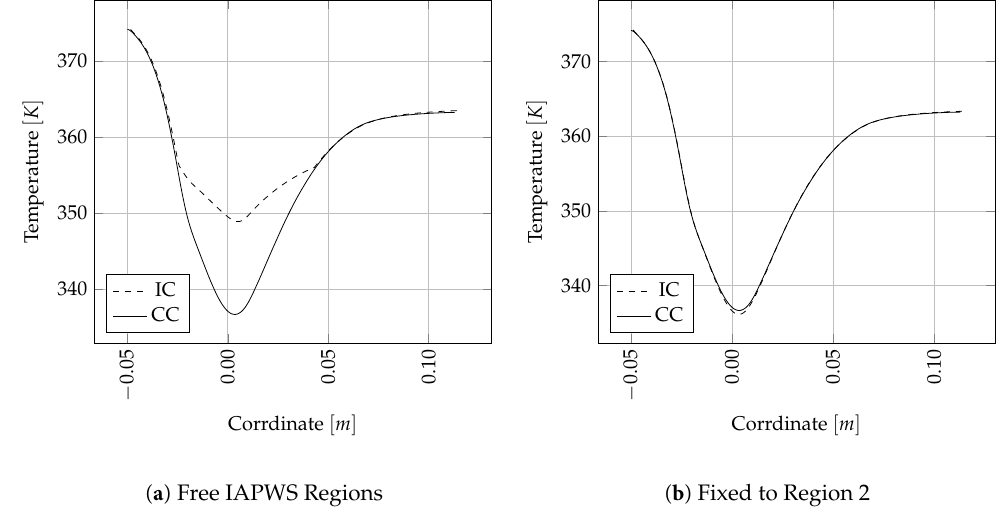
Figure 7. Influence of the presence of Region 4. In-house code (IC) vs. commercial code